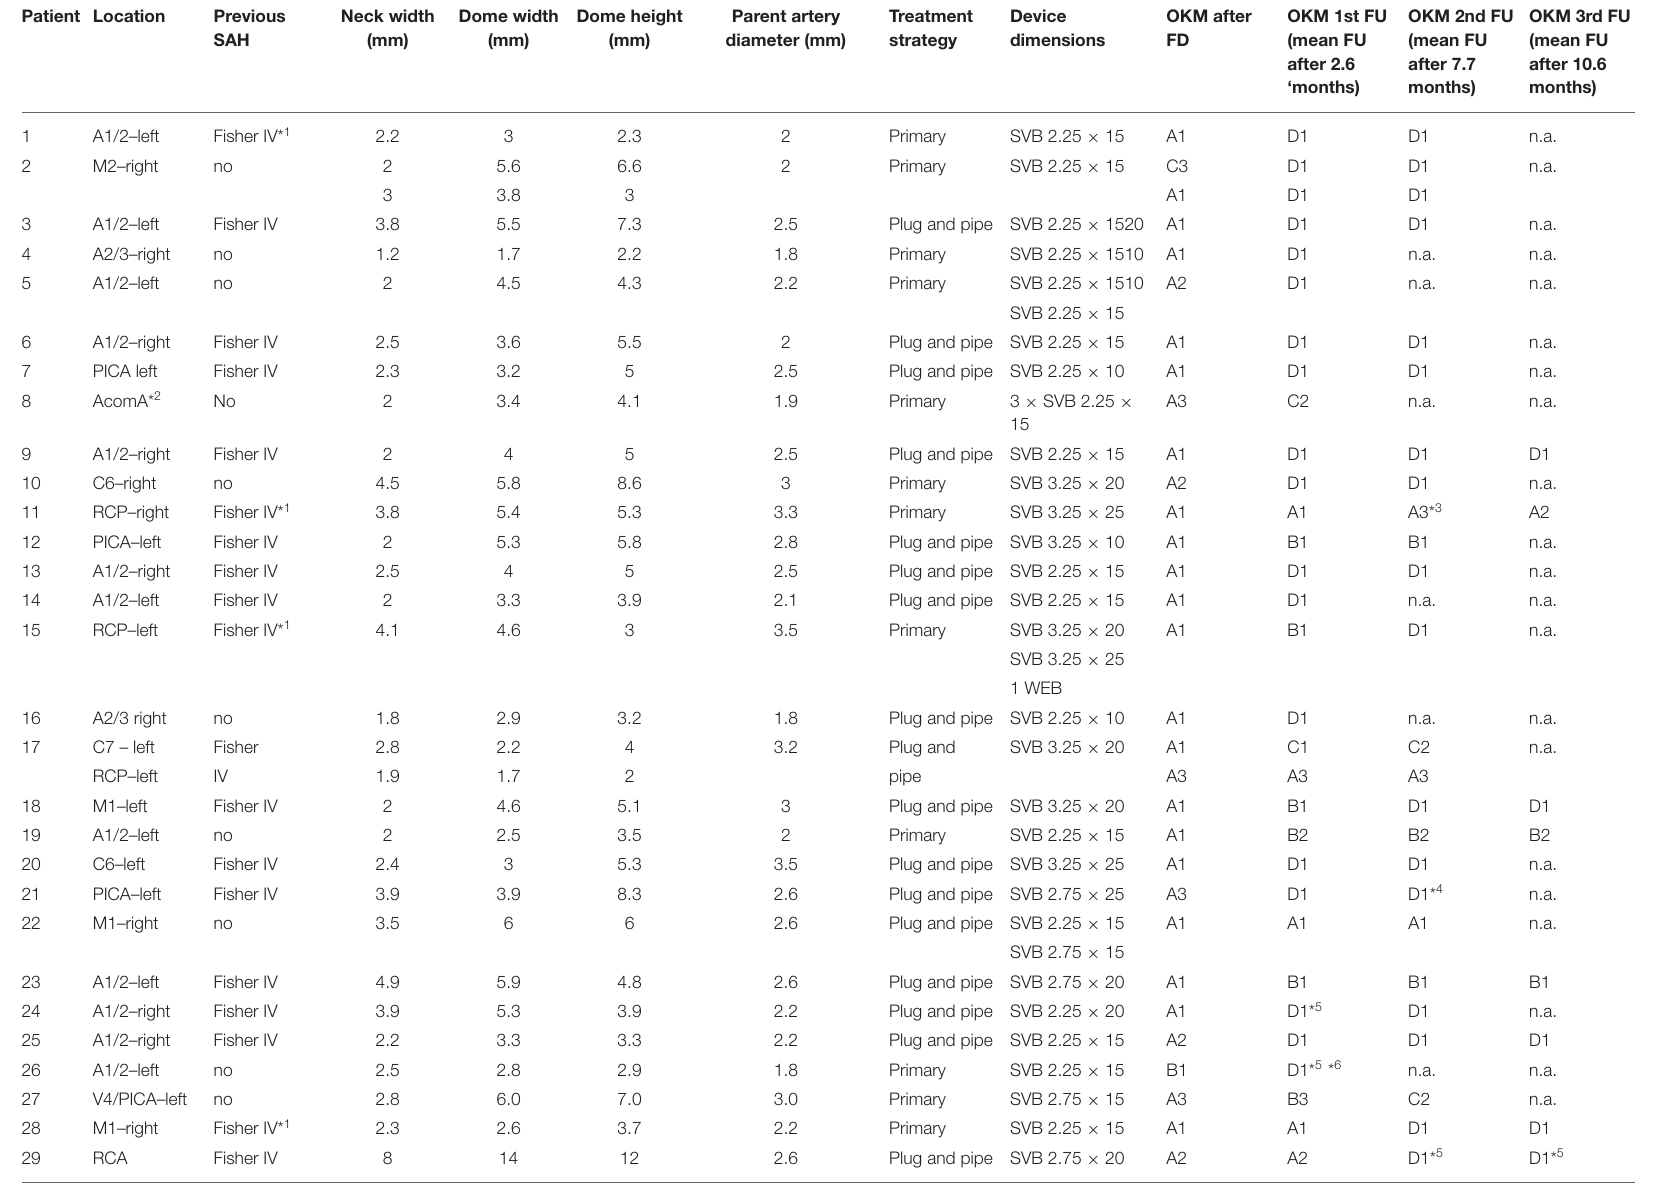
TABLE 1 | Demographic data and follow-up